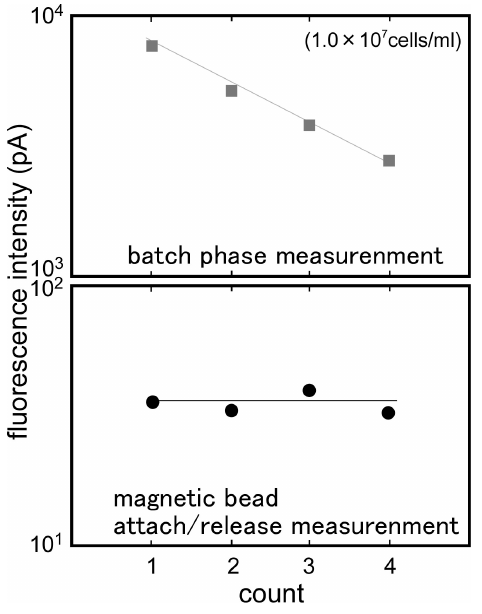
Figure 10. The parallel of the fluorometric output of the repetitive measurement using the same optical fiber between batch phase and magnetic bead attach/release measurements.